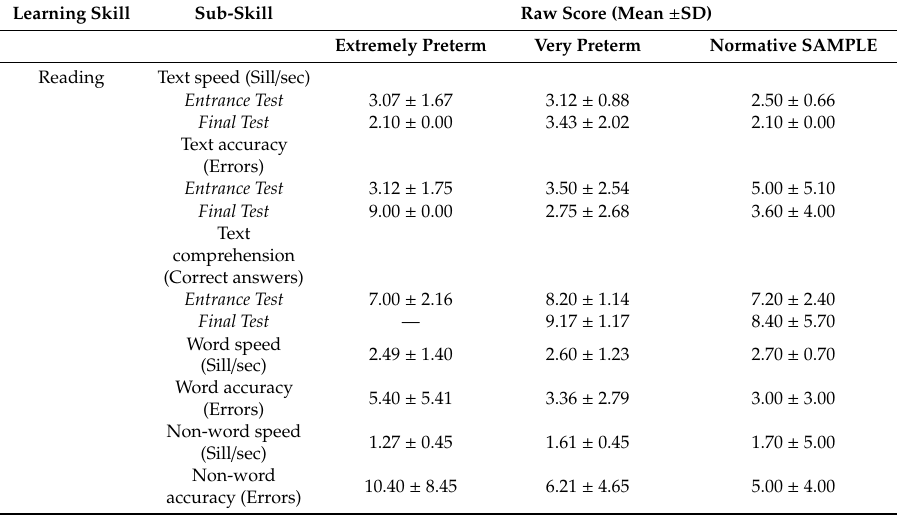
Table A2. Raw scores in learning skills in fourth grade